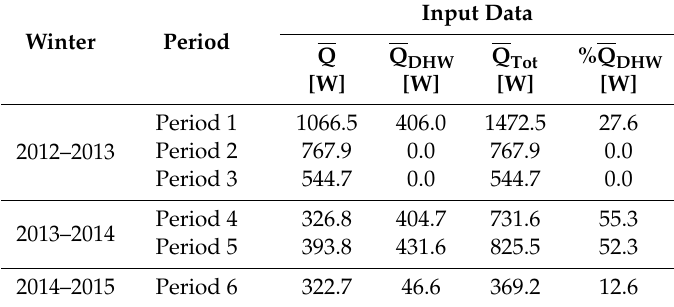
Table 5. Space heating (Q), Domestic Hot Water consumption (Q DHW ), total (Q Tot = Q + Q DHW ) and corresponding DHW percentage of the total (%Q DHW ) for the analysed periods in